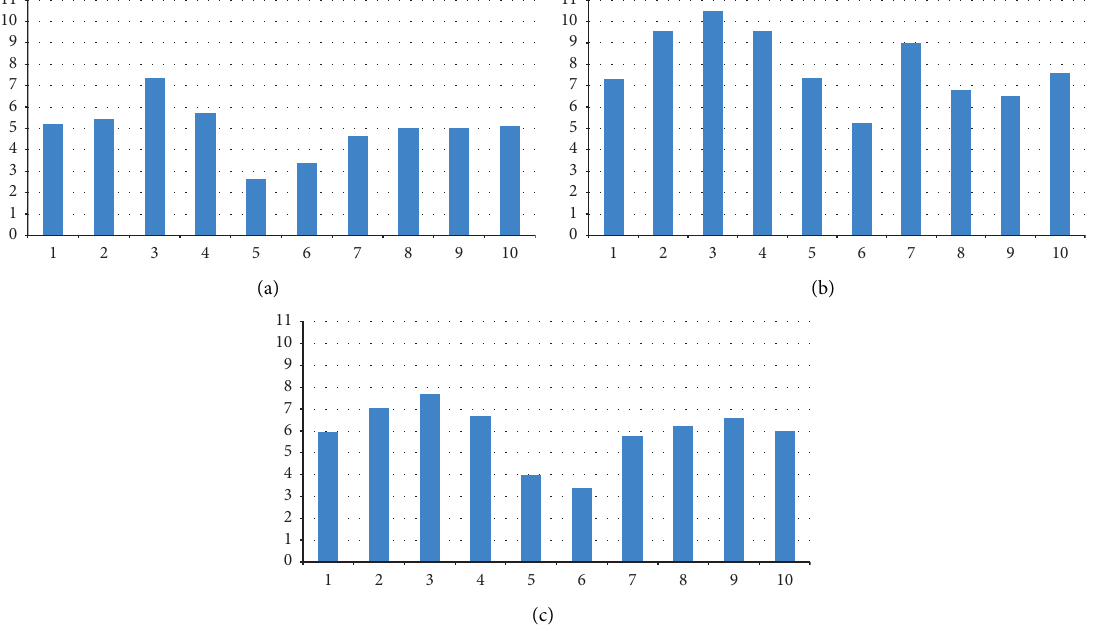
Figure 4: The NS value of the 10 sector indexes. (a) The calm period, (b) the pandemic period, (c) the post-pandemic period (the number on horizontal axis is the sector number in Table 1, and the number on vertical axis is the value of node strength).